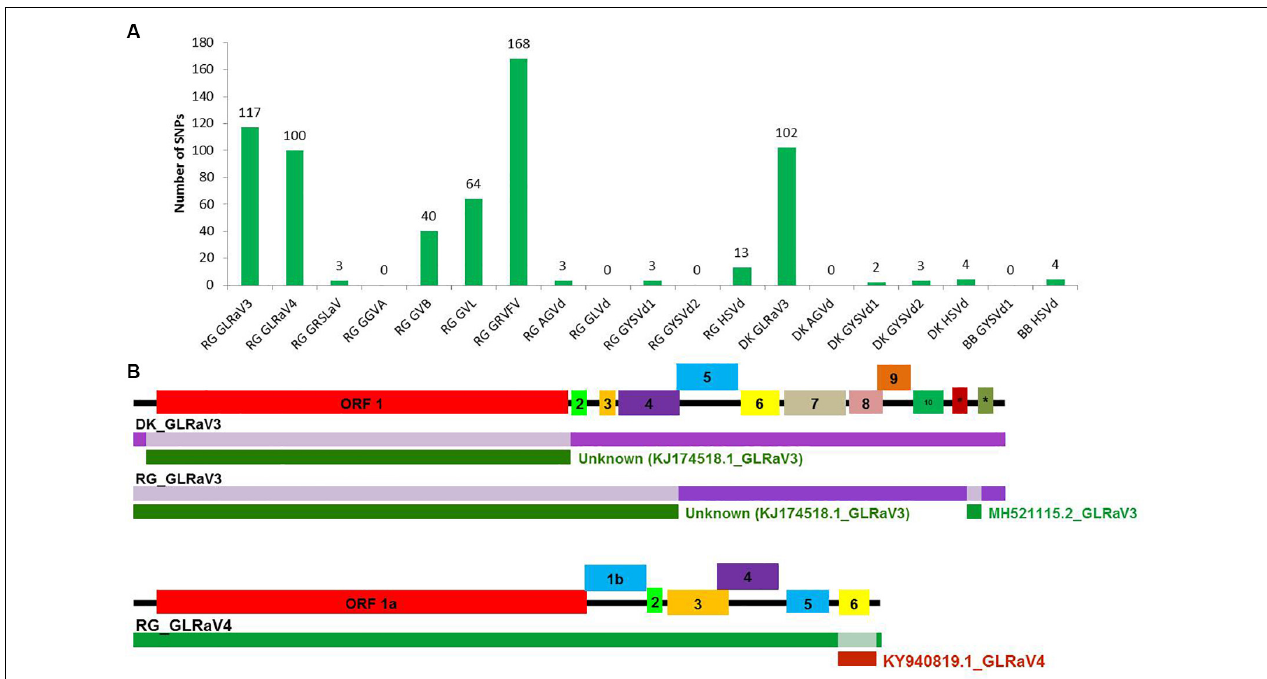
FIGURE 5 | SNP detection and recombination analyses in whole genome reconstructed viruses and viroids. The number of identified SNPs for each virus and viroid (A) . Identification of recombination events in reconstructed viral genomes using RDP4 program. (B) The positions of identified recombination events are indicated in a different color in the genome. The corresponding minor parental sequence is indicated by a differently colored bar below each event along with the name. #-ORF 11, *-ORF 12 in